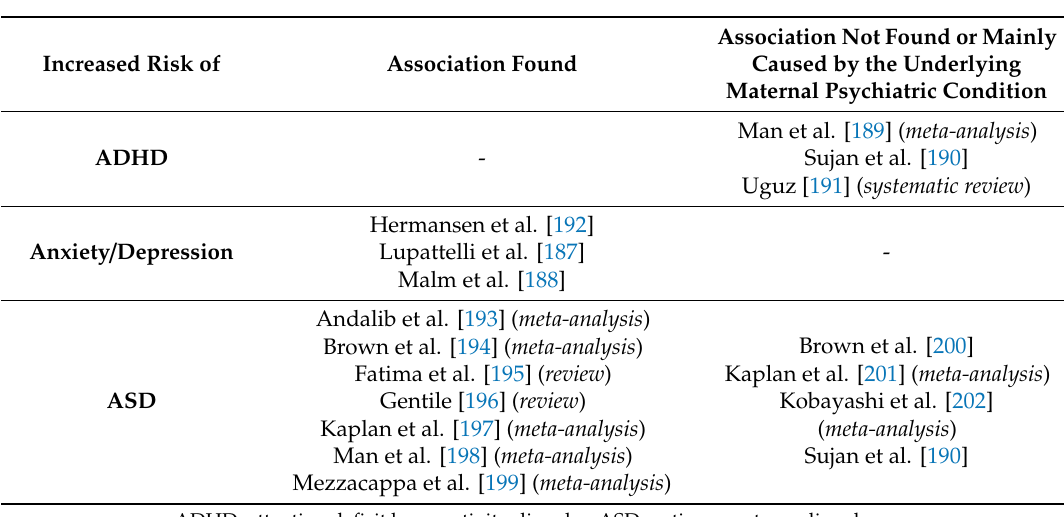
Table 2. Literature overview of associations between human maternal SSRI intake and child alterations. In depth information about the key characteristics of each article can be found in Table S1. We included meta-analyses but also case-control and cohort studies that were not included in one of the